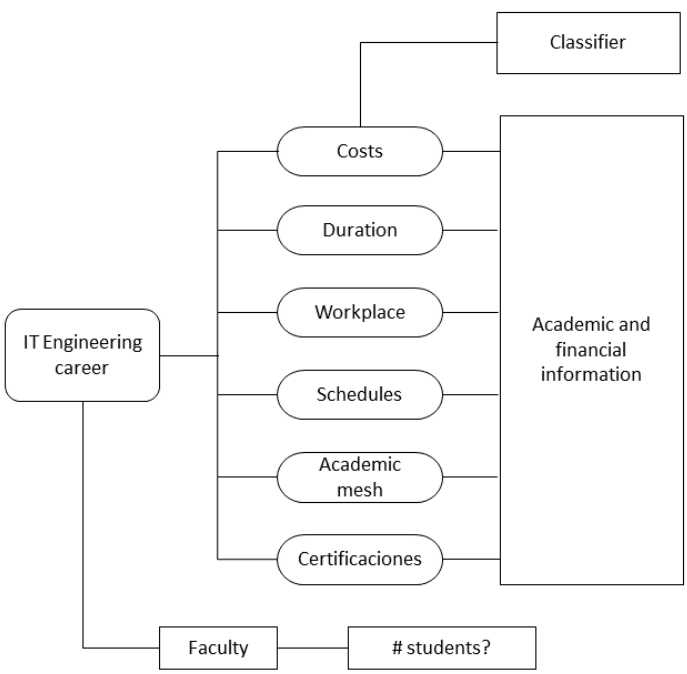
Figure 2. Taxonomy of frequent topics that are consulted by applicants for entry to the training programs of IT Engineering. Table 2. Knowledge base